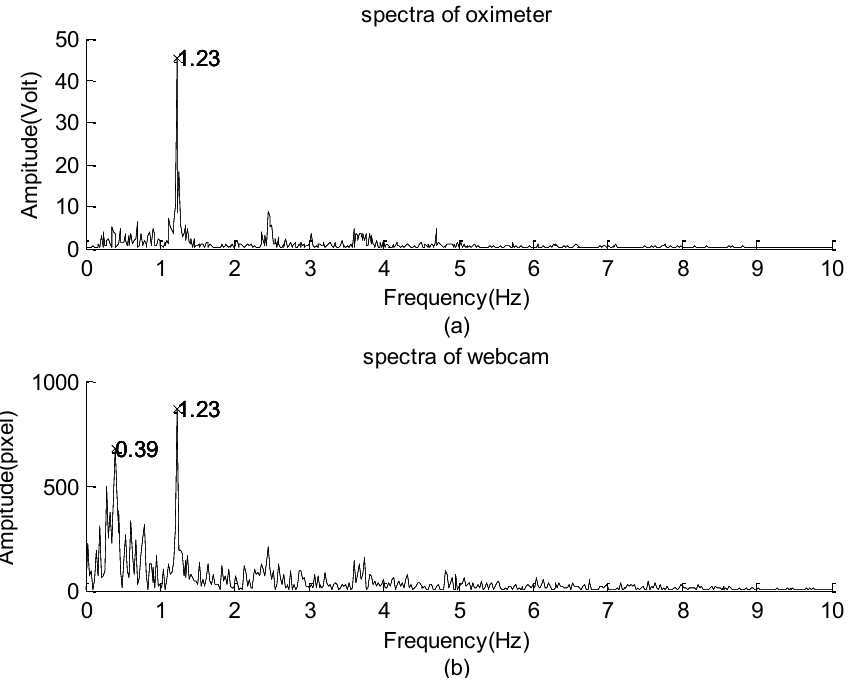
Figure 19. Spectra of the neck arterial pressure signal of an healthy adult: ( a ) the level of the blood-oxygen saturation captured by the pulse oximeter. ( b ) captured by the